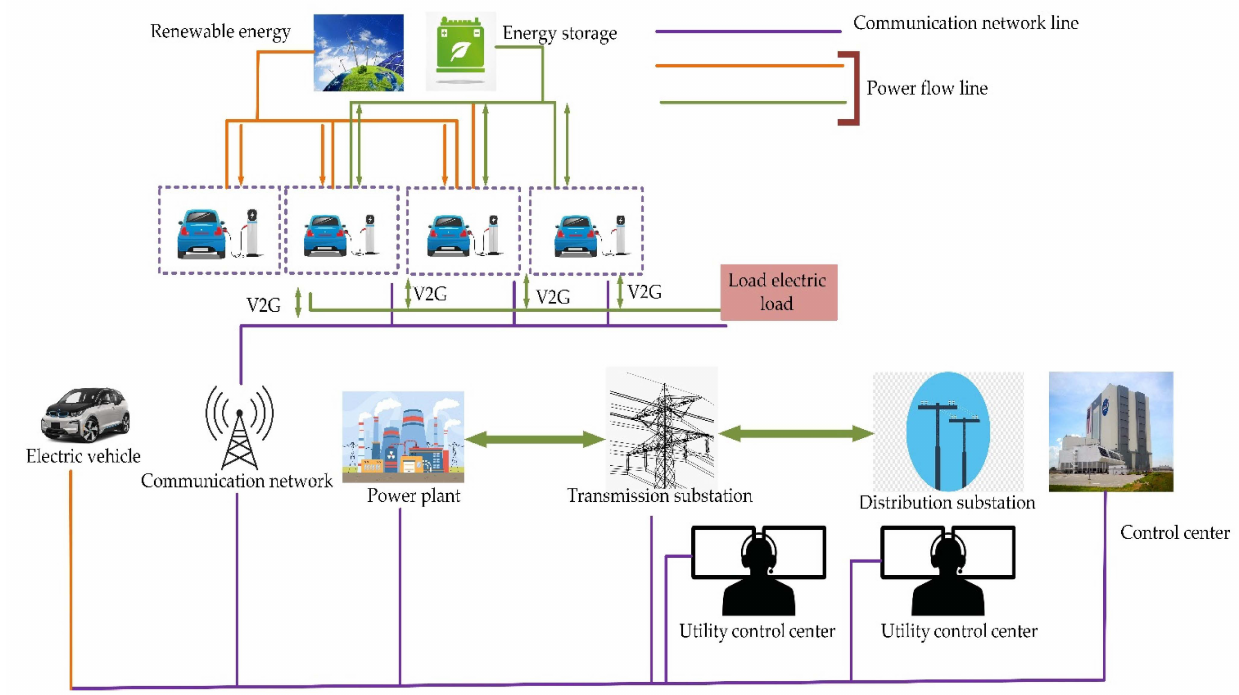
Figure 11. Schematic diagram of EV charging